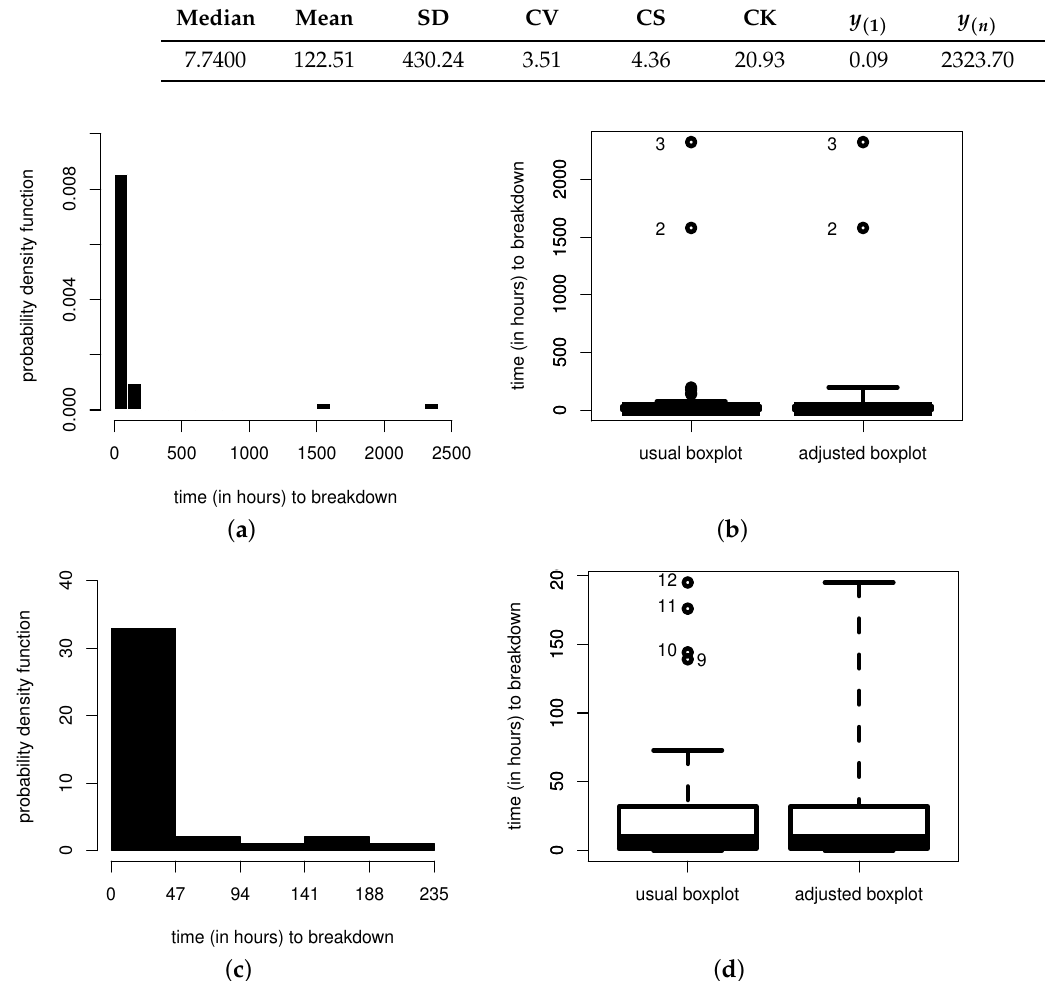
Figure 1. Histogram ( a ) and boxplots ( b ) for the data of times to electrical breakdown with the full data set, and histogram ( c ) and boxplots ( d ) for the data set without cases #2 and